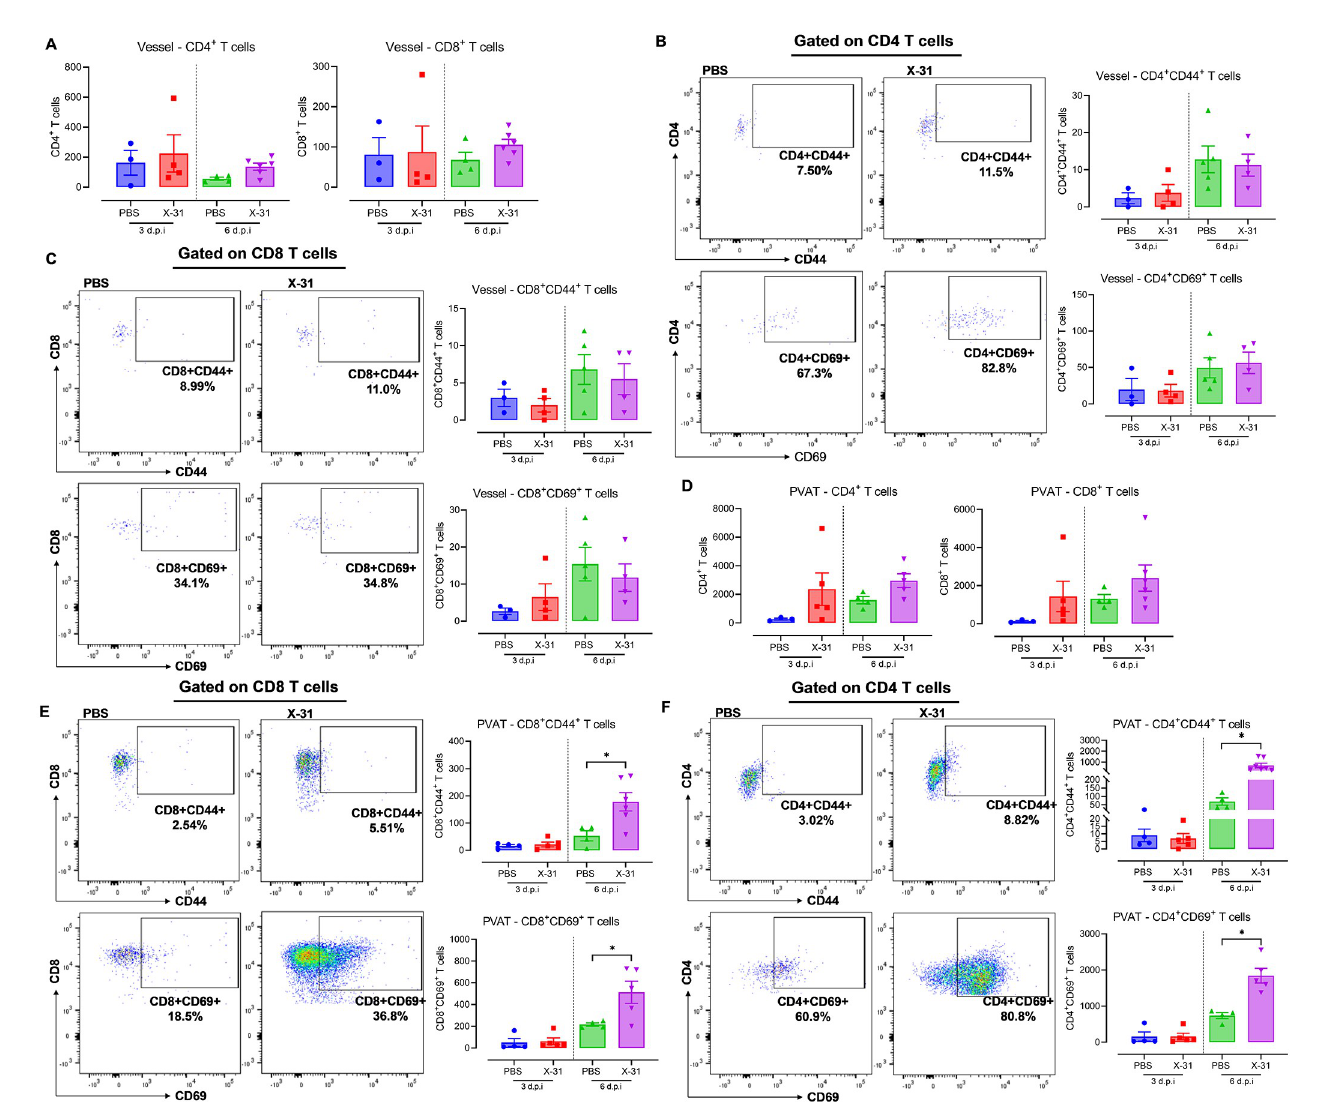
Fig 6. IAV drives immune T cell infiltration and activation predominantly in the PVAT of pregnant mice when compared to the arterial wall. Separate single cell suspensions were prepared from vessel wall and PVAT digests from pregnant mice that were inoculated with either PBS or Hk-x31 virus (X-31; 10 4 PFU) at 3 and 6 d.p.i and quantified via flow cytometry for the following cell subsets. (A) Vessel wall analysis showing CD4 + and CD8 + T cells at 3 and 6 d.p.i. (B—C) Representative X-31 dot plots and quantification showing PBS and X-31 CD44 + and CD69 + activated CD4 + and CD8 + T cells in the vessel wall. (D) PVAT analysis showing CD4 + and CD8 + T cells at 3 and 6 d.p.i. (E—F) Representative X-31 dot plots and quantification showing PBS and X-31 CD44 + and CD69 + activated CD4 + and CD8 + T cells in the PVAT. All cell populations are measured as absolute number of CD45 + population per 25,000 counting beads. Data are represented as mean ± SEM (pregnant PBS, n = 3–6; pregnant X-31, n = 4–6; of at least two independent experiments). Statistical analysis was performed using unpaired t-test against their respective PBS control. � P <